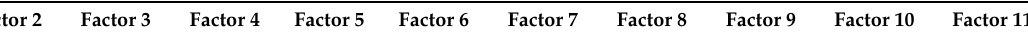
Table A3. Total Variance